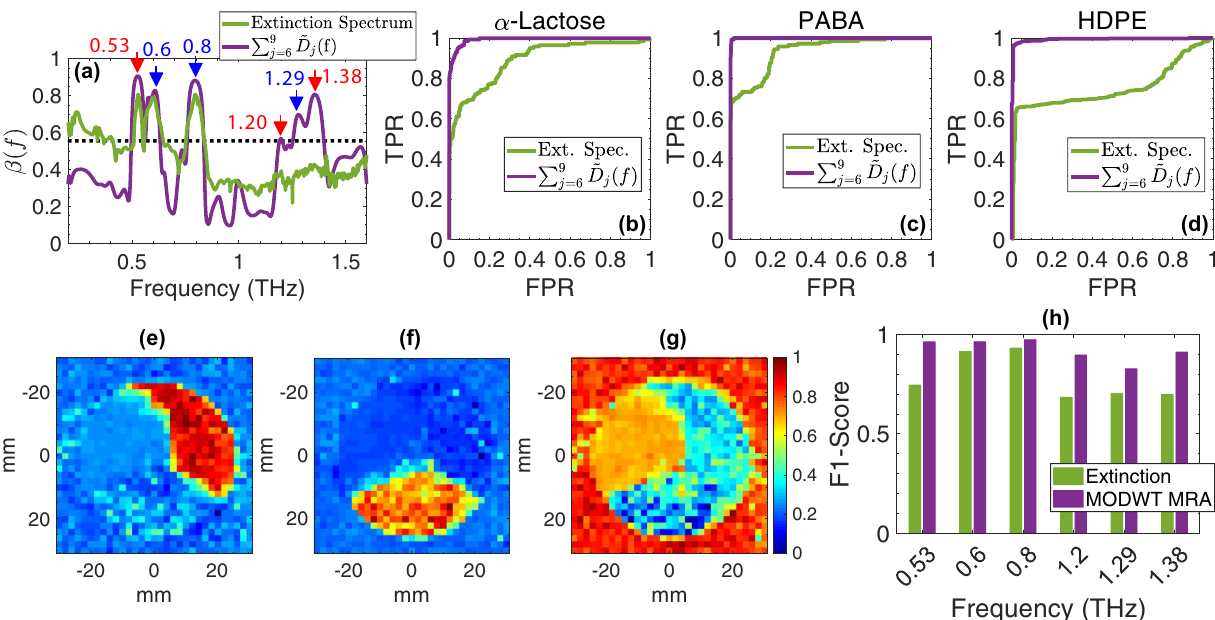
Figure 3. The bimodality-based MODWT MRA at θ = 0 ◦ , ( a ) the bimodality coefficient of the images formed from the extinction spectra and the MODWT MRA in the range 0.2–1.6 THz, ( b - d ) the receiver operating characteristic (ROC) curves obtained for identification of the region of each chemical using the component spatial pattern analysis based on the extinction spectra and the bimodality-based MODWT MRA, ( e - g ) the chemical maps (jet color map generated in MATLAB R2020b, https:// www. mathw orks. com/ produ cts/ matlab) obtained using the component spatial pattern analysis based on the MODWT details for α -lactose, PABA, and HDPE, respectively, ( h ) comparison of the F1-scores obtained for chemical mapping at each resonant frequency using the extinction spectra and the MODWT detail